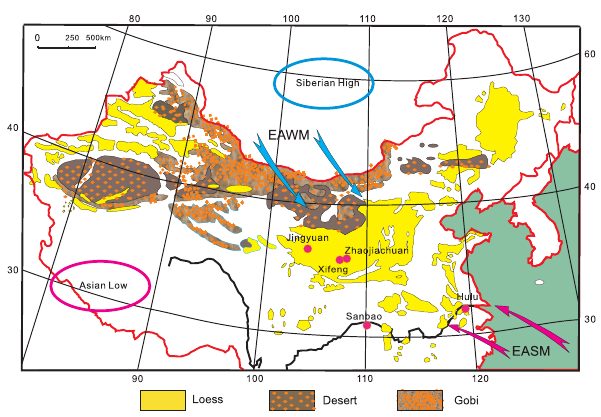
Fig. 1. Map showing the atmospheric circulation regime in East Asia and the locations of the sites of geological data used in this study. EASM – East Asian summer monsoon, EAWM – East Asian winter